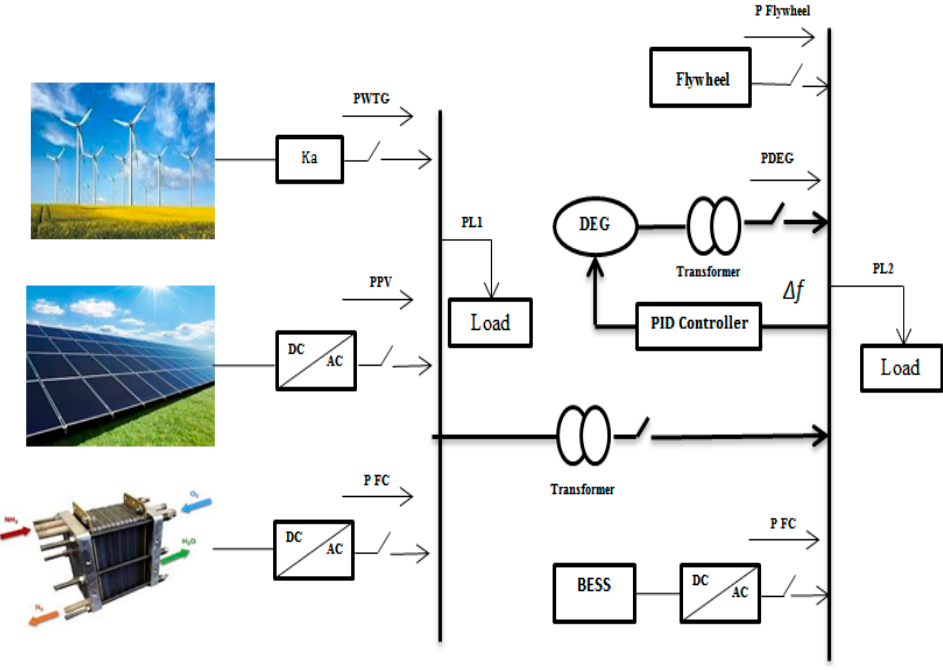
Figure 1. General structure of a microgrid.